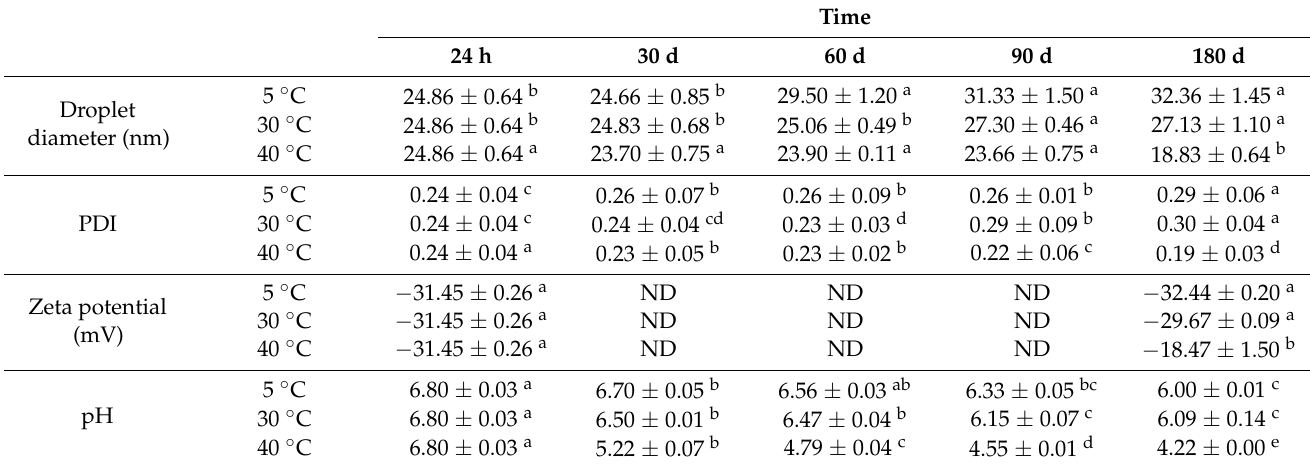
Table 2. Droplet diameter, PDI, zeta potential, and pH of the HA-based nanoemulsion containing P. pubescens oil stored at temperatures of 5, 30, and 40 ◦ C for 180